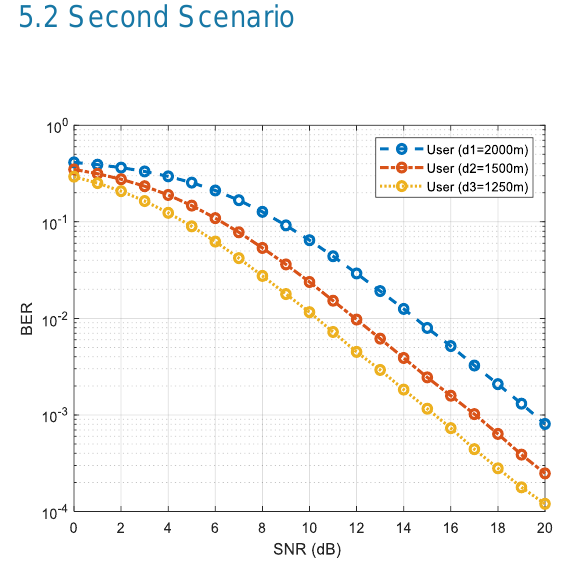
Figure 7. BER against SNR for one user with different distances Figure.7 appears the BER performance for one user versus SNR at (100KHz) BW and (0.4) power coefficients for different distances. The effect of different distances appeared with increasing SNR. As the distance changed from (2 to 1.5) Km the BER rate improved by (6.00E-04) and the distance changed from (1.5 to 1.25) Km change the BER rate enhanced by (1.00E-04) at SNR of (20dB).